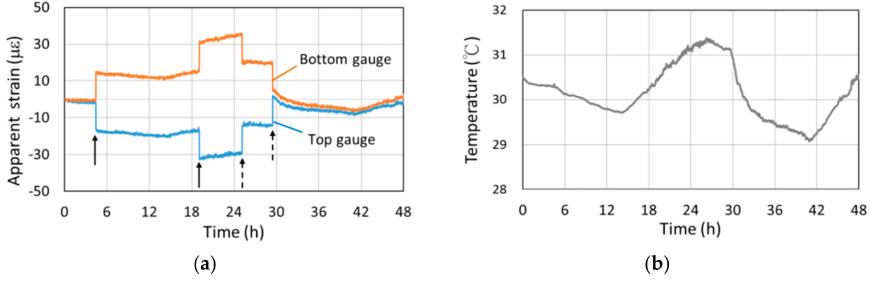
Figure 7. The steel beam test: ( a ) strain gauge response; ( b ) temperature changes.